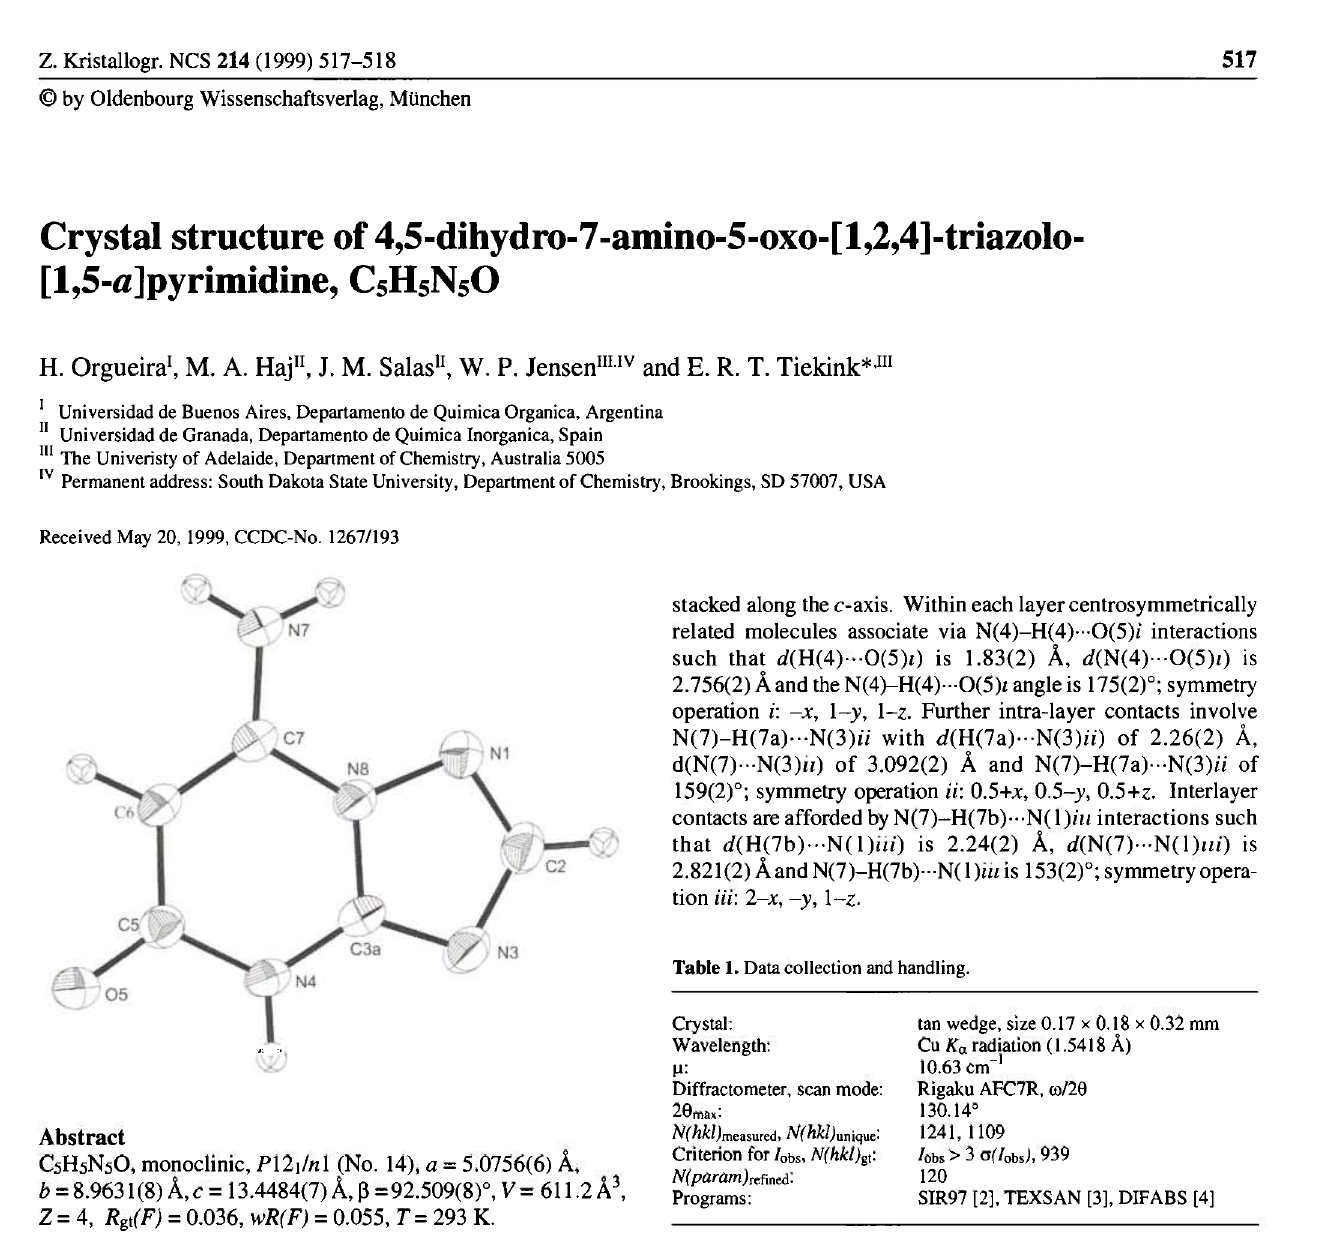
Table 1. Data collection and handling.